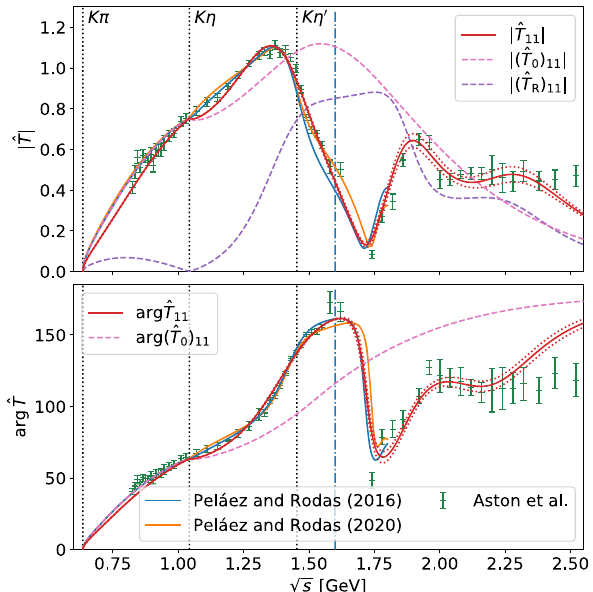
Fig. 2 Results for the combined fit of argument and absolute value of ˆ T , defined in Eq. (18), with 1 σ uncertainty band to the corresponding data of Aston et al. [63]. We furthermore show the results of Peláez and Rodas (2016) [64] for comparison, which by the authors are quoted to be valid up to the dash-dotted line at 1 . 6GeV, and the newer results of Peláez and Rodas (2020) [7]. We moreover show the low-energy